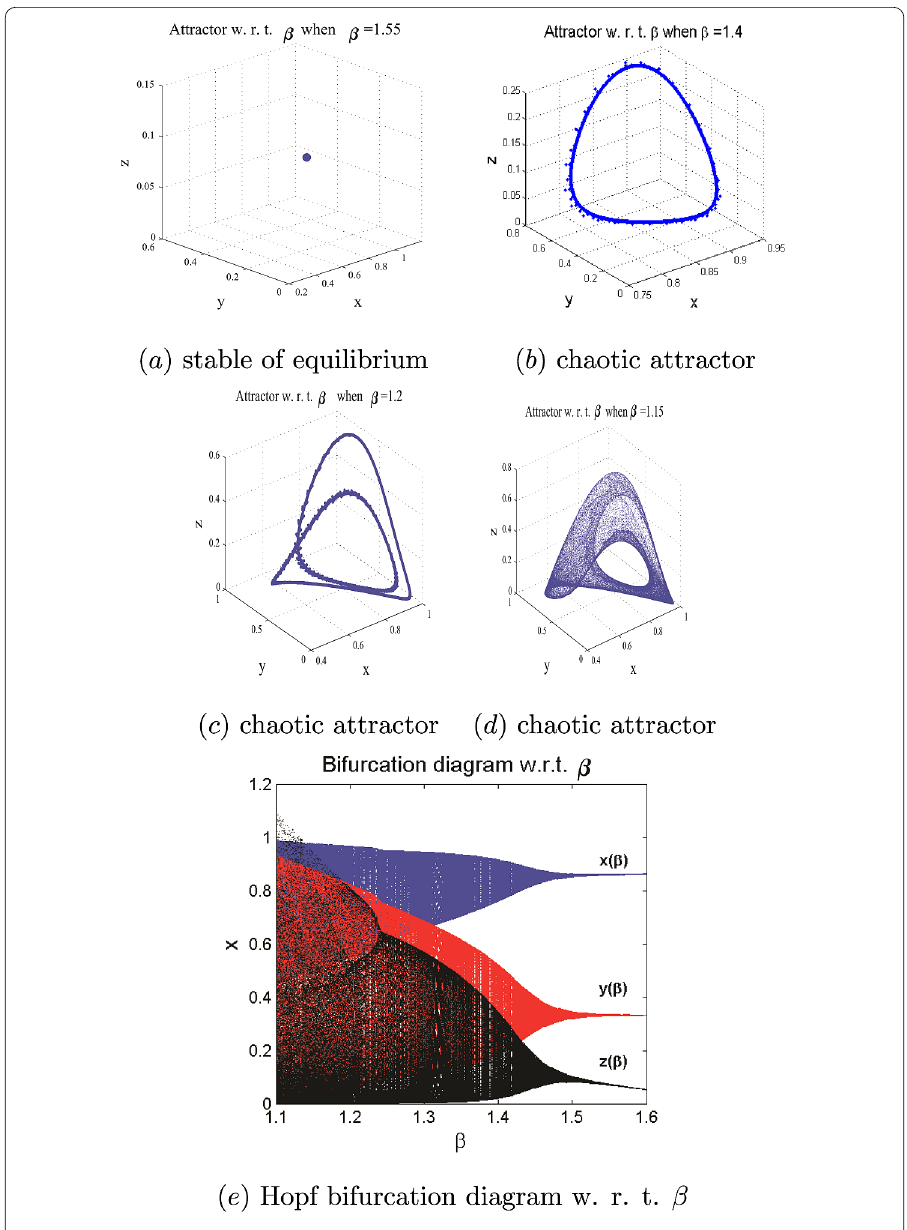
Figure 4 Hopf bifurcation diagram with respect to β